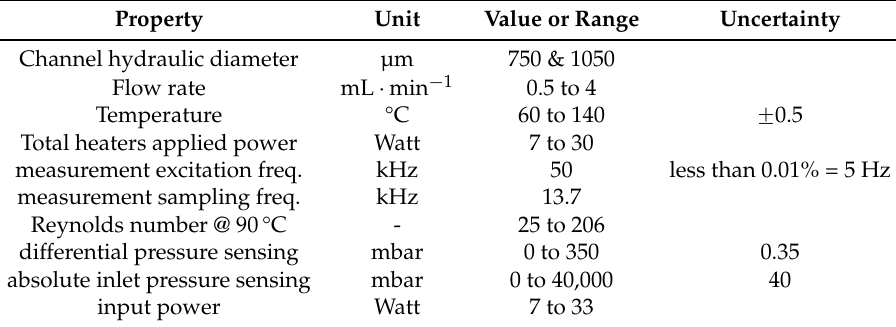
Table 1. Experimental parameters and uncertainties [35,38,39].